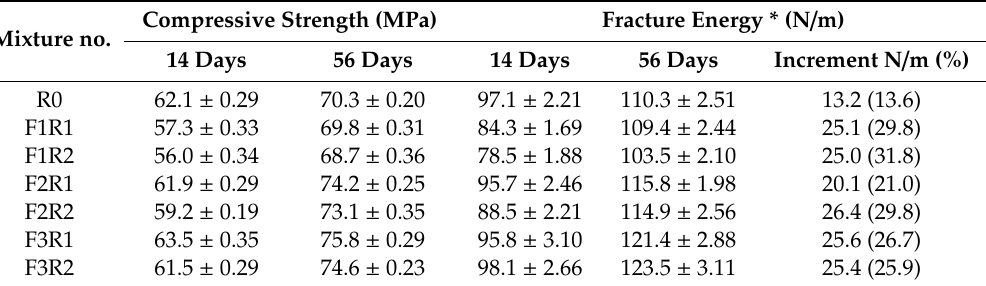
Table 5. Fracture energy of concrete.